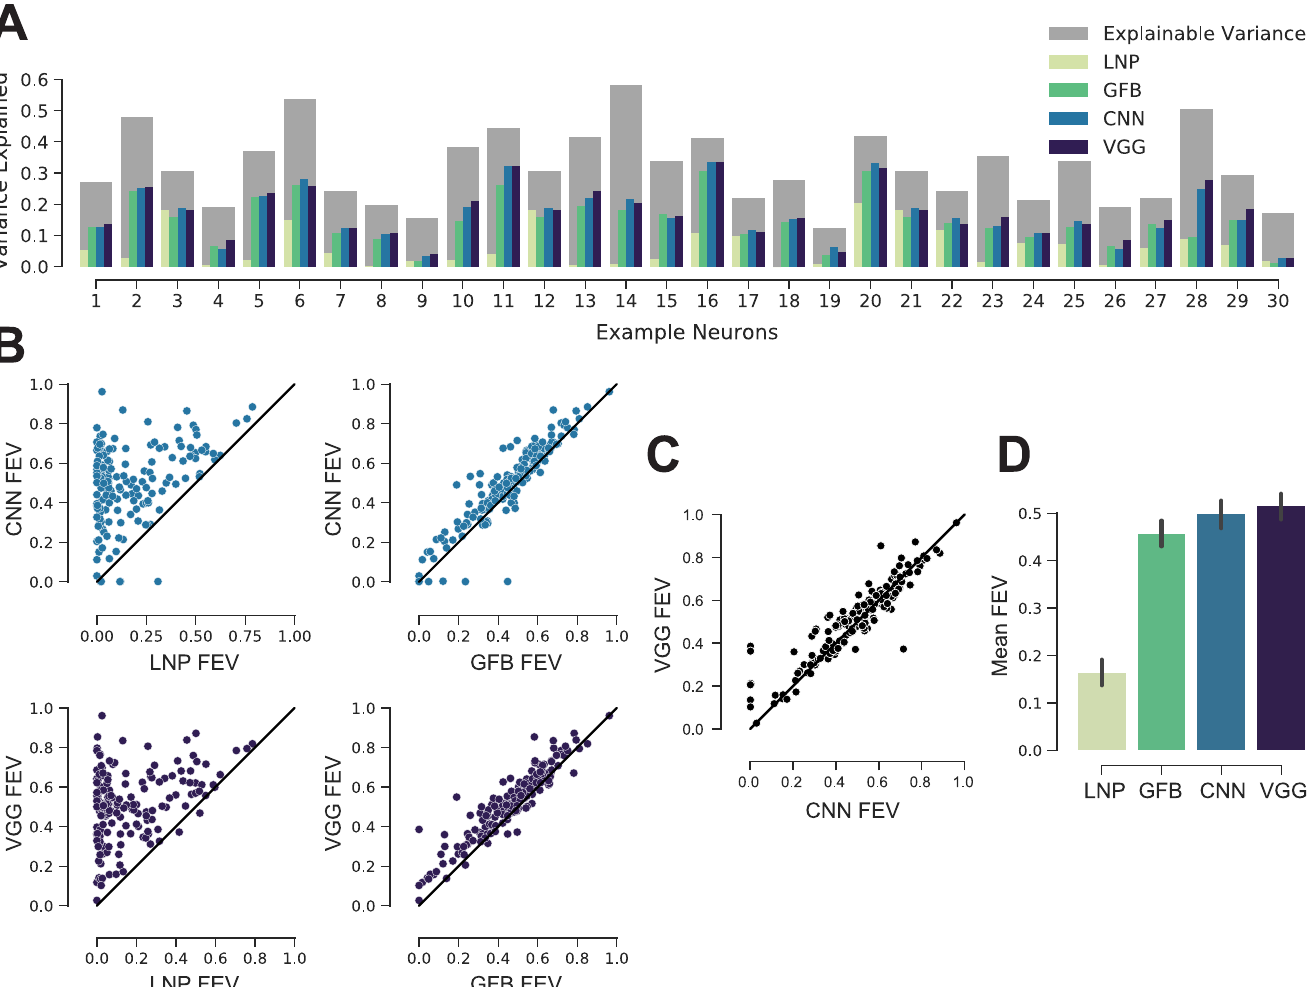
Fig 8. Deep models are the new state of the art. A: Randomly selected cells. The normalized explainable variance (oracle) per cell is shown in gray. For each cell from left to right, the variance explained of: regularized LNP [46], GFB [22, 47, 48], three-layer CNN trained on neural responses, and VGG conv3_1 model (ours). B. CNN and VGG conv3_1 models outperform for most cells LNP and GFB. Black line denotes the identity. The performance is given in FEV . C: VGG conv3_1 features perform slightly better than the three-layer CNN. D: Performance of the four models in fraction of explainable variance explained ( FEV ) averaged across neurons. Error bars show 95% confidence intervals of the population means. All models perform significantly different from each other (Wilcoxon signed rank test, n = 166; family-wise error rate α = 0.05 using Holm-Bonferroni method to account for multiple comparisons).